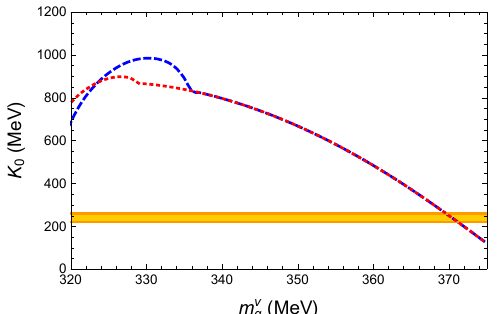
Figure 2 . The compressibility K 0 of quarkyonic matter at saturation density n 0 as a function of the quark vacuum mass m v for both linear (red dotted) and nonlinear (blue dashed) (cid:22) 0 q The yellow band is the constraint from experiments [32].